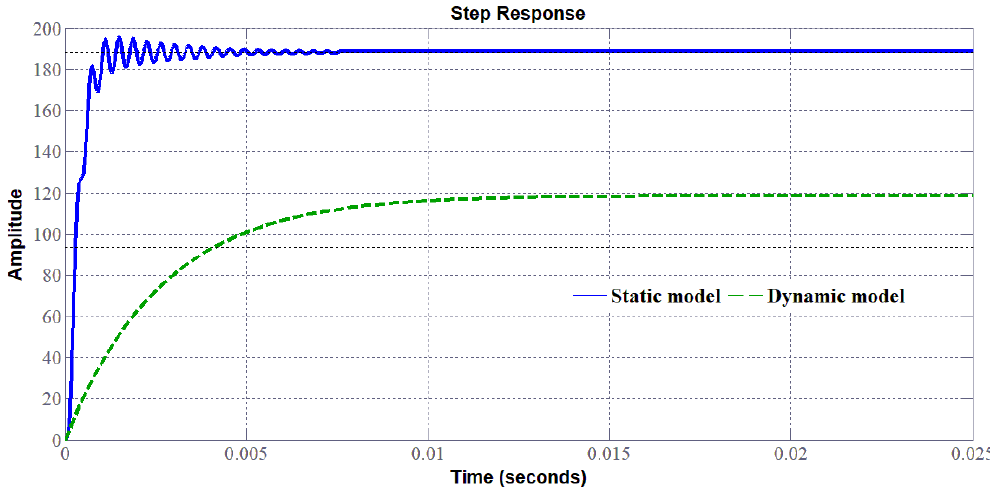
Figure 24. Slow response of the system with the dynamic model.